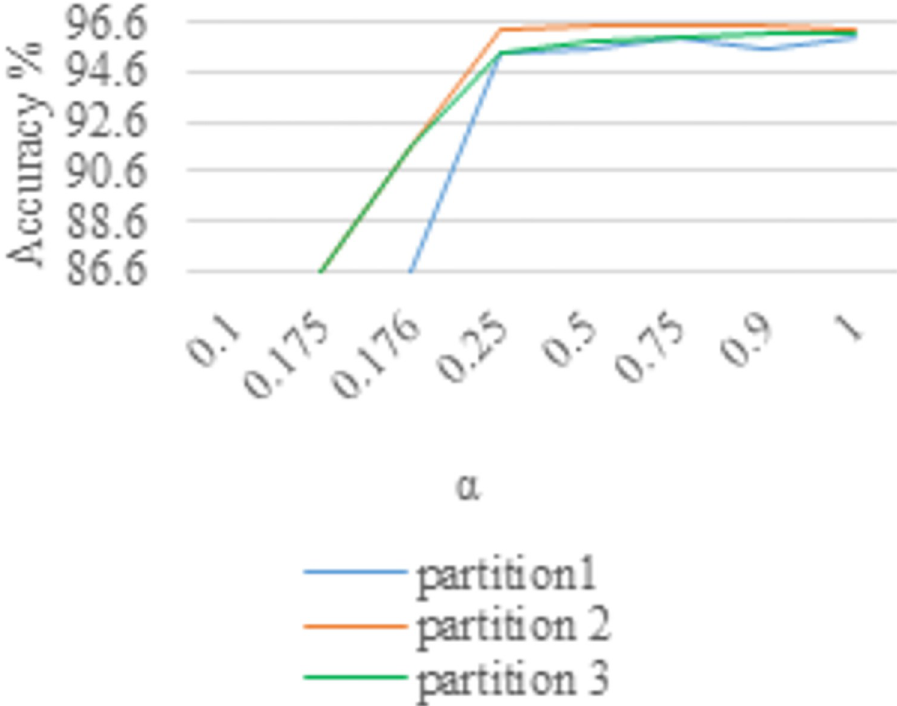
Fig 9. The influence of different values of α on UCF-101 about